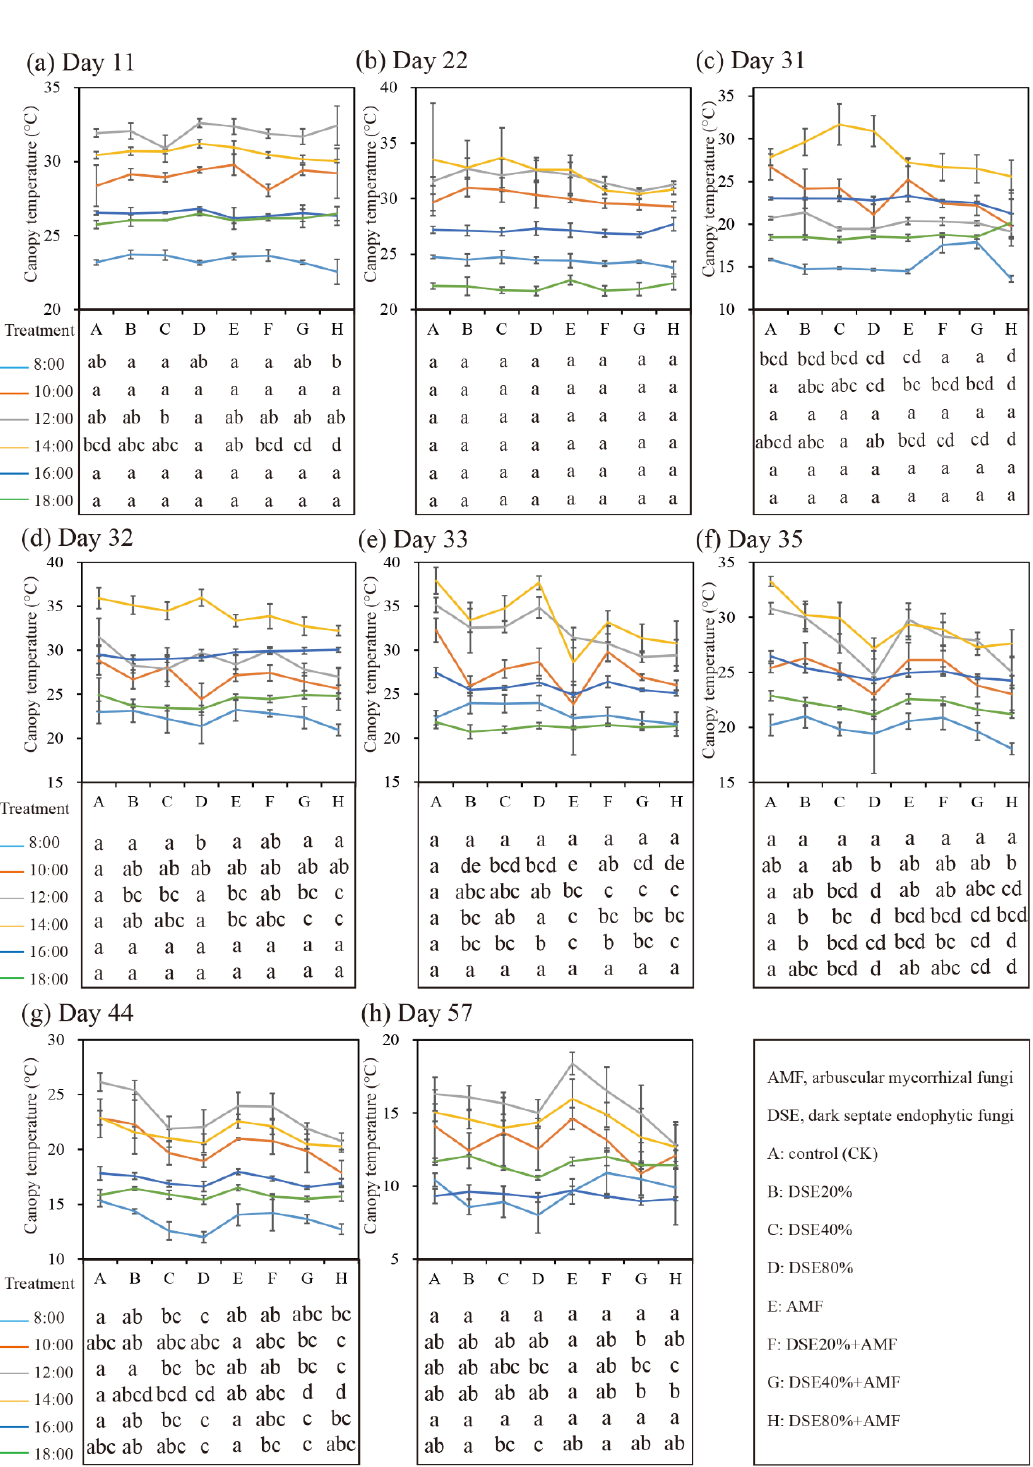
Figure 2. Plant canopy temperature undergoing different treatments on the ( a ) 11th, ( b ) 22nd, ( c ) 31st, ( d ) 32nd, ( e ) 33rd, ( f ) 35th, ( g ) 44th and ( h ) 57th days. An analysis of variance (ANOVA) was used to analyze the data at the same time every day. Control (CK), treatments with sterilized DSE and AMF; DSE20%, 2 × 10 5 CFU mL −1 of DSE with sterilized AMF; DSE40%, 4 × 10 5 CFU mL −1 of DSE with sterilized AMF; DSE80%, 8 × 10 5 CFU mL −1 of DSE with sterilized AMF; AMF, sterilized DSE with AMF; DSE20% + AMF → DSE80% + AMF, with different concentrations of DSE and AMF. Different letters above the columns are significantly different at p < 0.05.